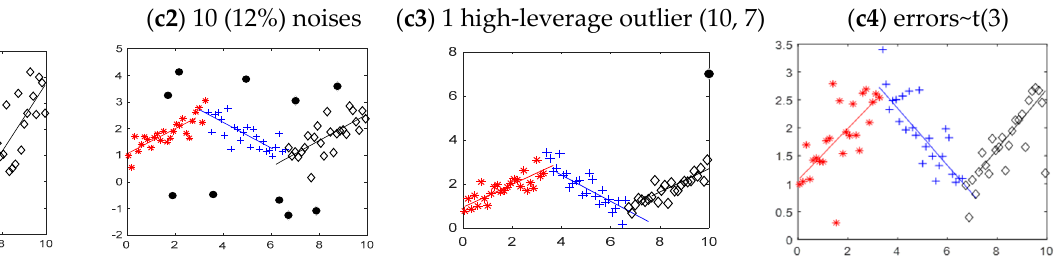
Figure 3. Plots of Model (c), true parameters and one simulated series from each respective contam- ination scenario. Model expression E ( y ) = β i 0 + β i1 x , β i = ( β i 0 , β i 1 ) (cid:48) ; i = 1, 2, 3; β *: (1, 0.5), + : (4.3, − 0.5),